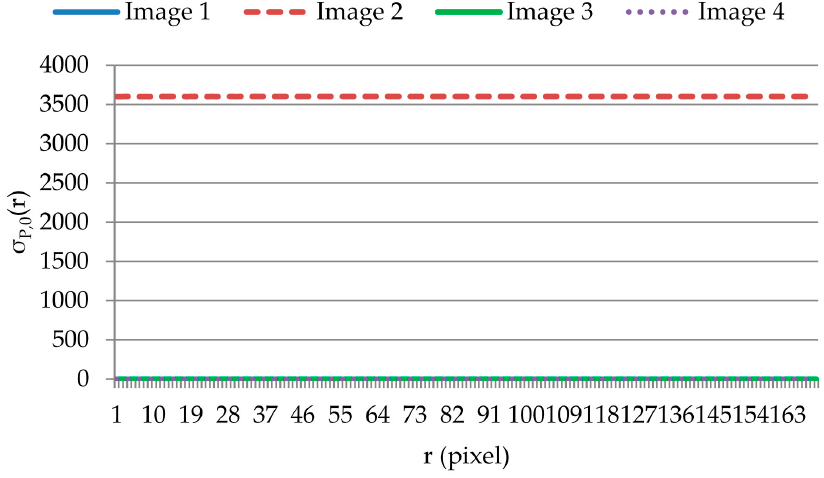
Figure 8. Variance projection features of texture ‐ less searching images.